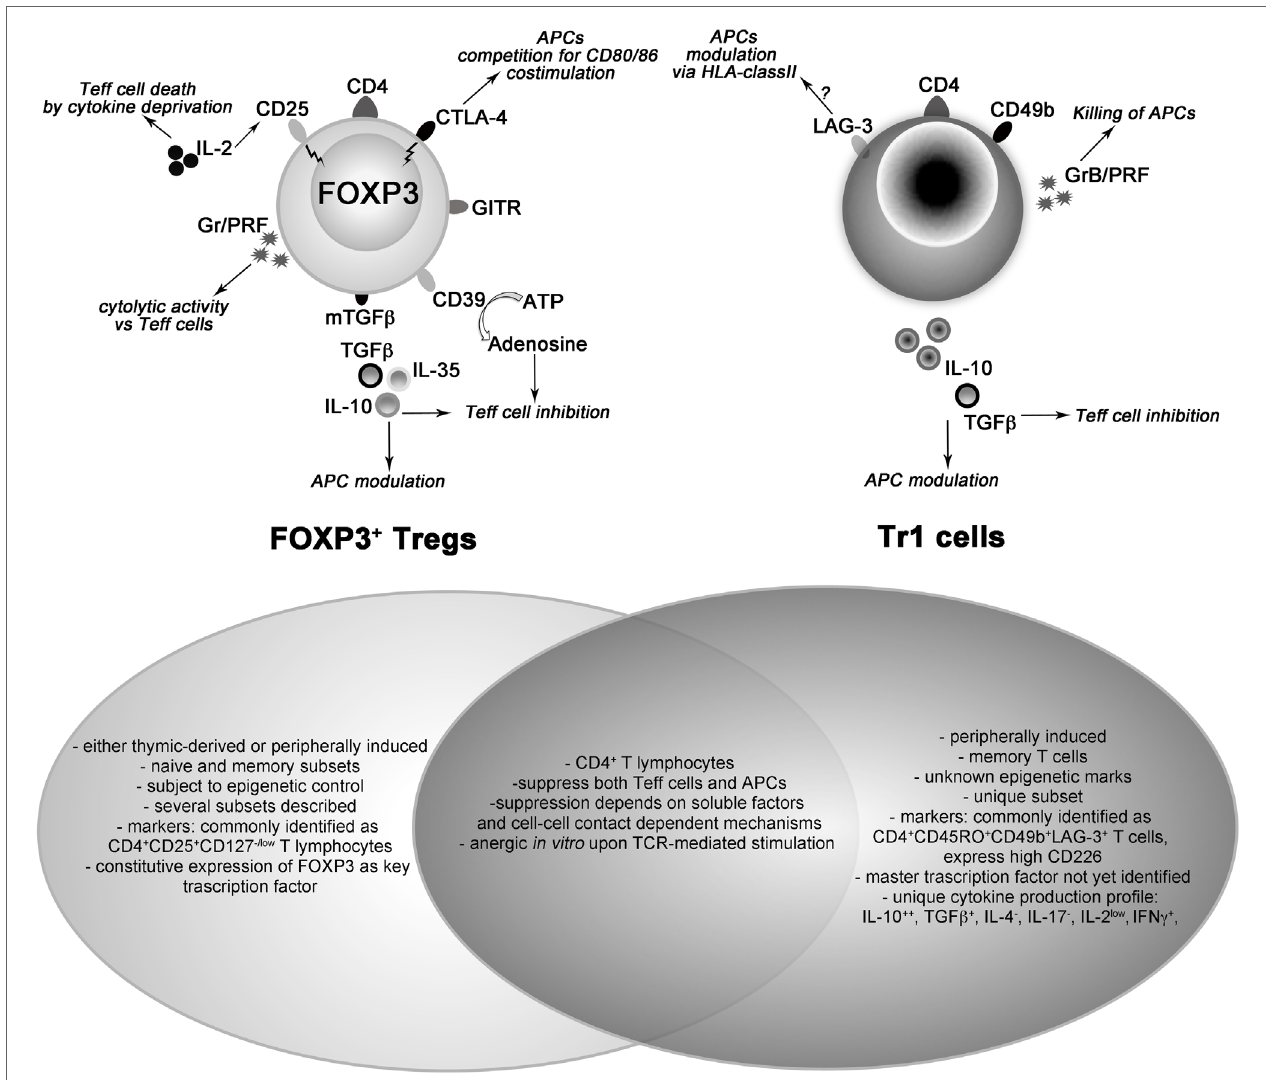
FiGUre 1 | schematic representation of cell surface and intracytoplasmic markers and mechanisms of action characterizing FOXP3-expressing (left cartoon) and type 1 (right cartoon) t regulatory cells . The shared and unique features of both cell types are listed in the frames. Ag, antigen; APC, antigen- presenting cell; ATP, adenosine triphosphate; CTLA-4, cytotoxic T-lymphocyte antigen 4; FOXP3, forkhead box protein 3; GITR, glucocorticoid-induced TNFR family related gene; Gr; Granzymes; LAG-3, lymphocyte-activation gene 3; PRF, perforin; Teff, effector T cell; TGF β , transforming growth factor β ; Tr1, type 1 T regulatory